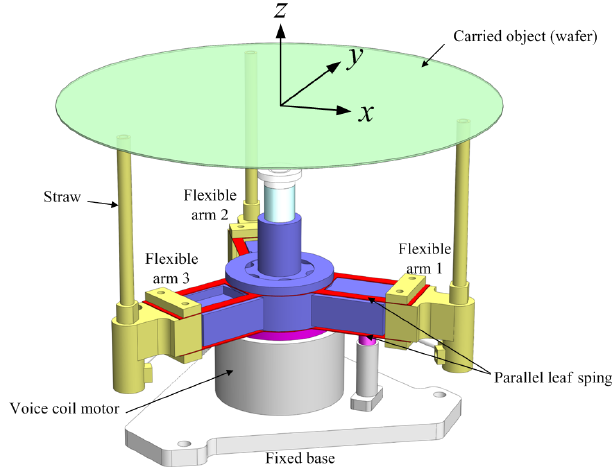
Figure 2. A computer-aided design (CAD) model of a PLCM.